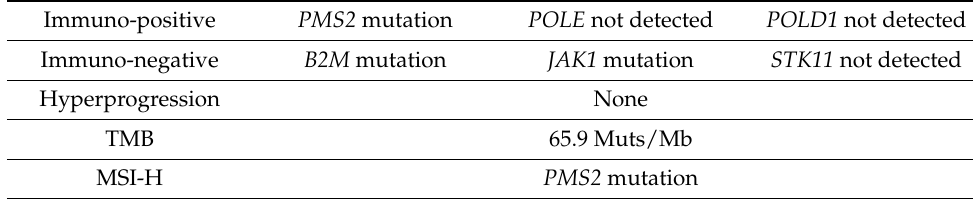
Table 1. Detection of immunotherapy related predictors.